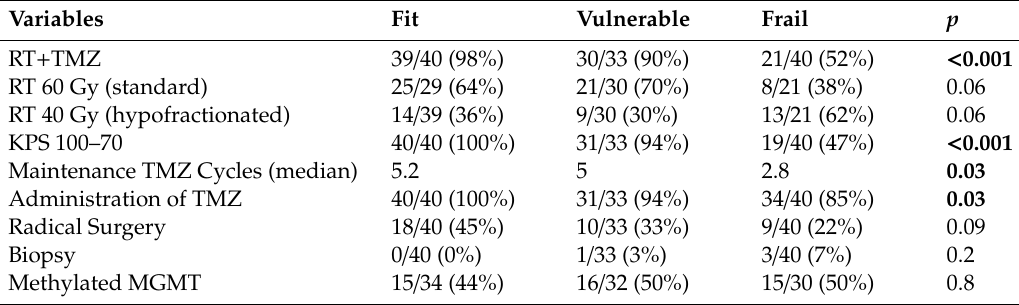
Table 2. Association of clinical factors and CGA